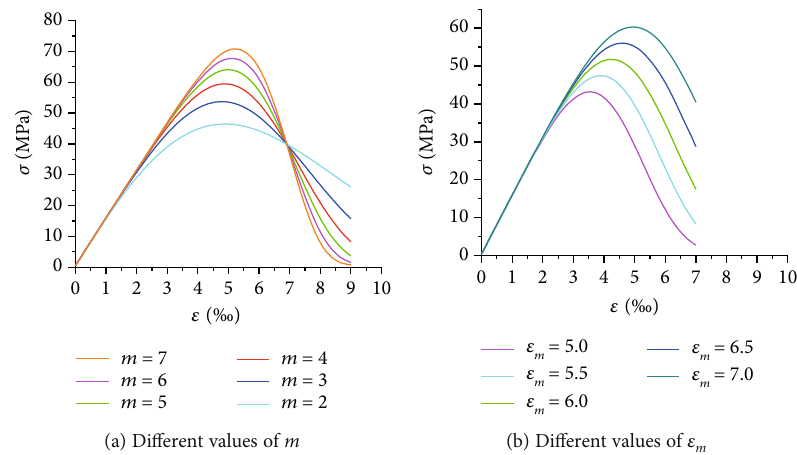
Figure 2: The variations of the theoretical curve with di ff erent values of m and ε